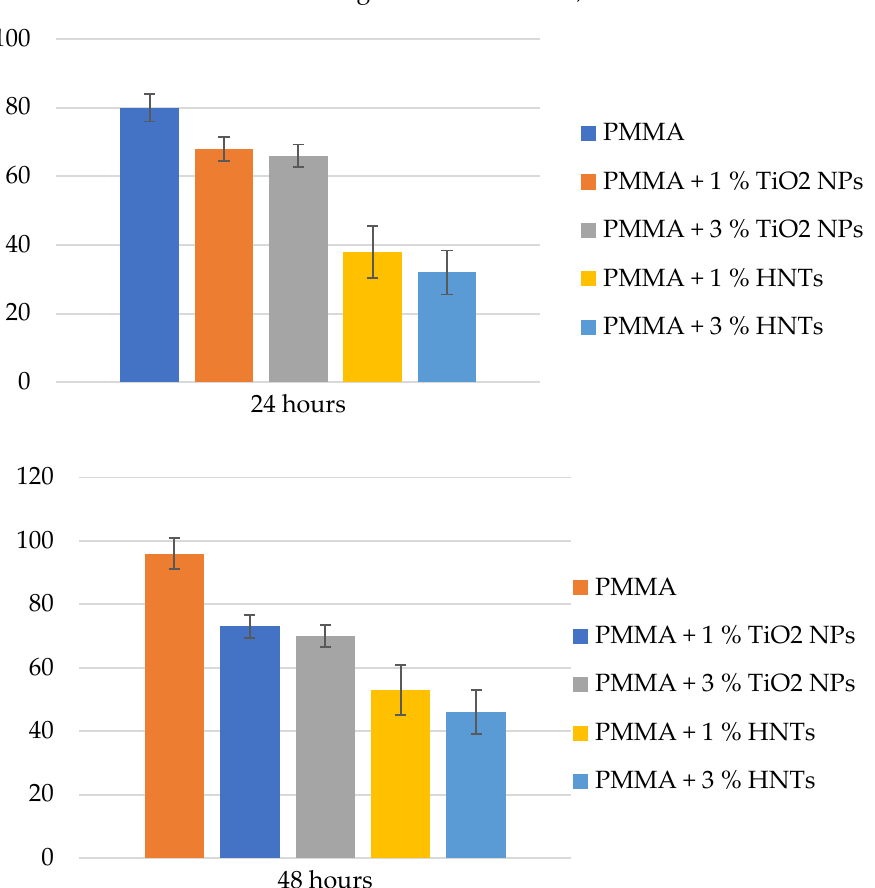
Figure 5. Histograms reporting the colonization assay measurements of C. albicans on (PMMA) and different PMMA-based substrates. The colonized area was expressed as a percentage rate representing the area covered by C. albicans in respect to the entire surface at two time points (24 h and 48 h). Reported results were calculated as average ± SD for three different areas of each sample, and the values were considered statistically significant in respect to control (PMMA at corresponding time point) for a p -value < 0.005.